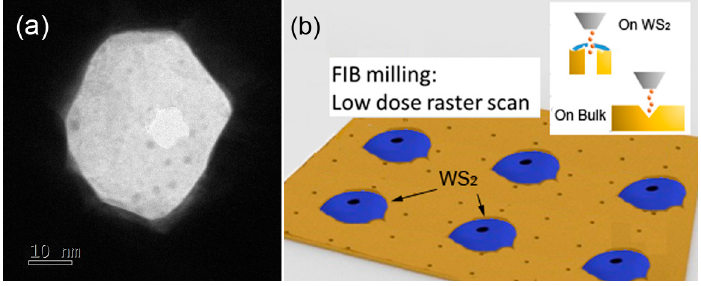
Figure 7. ( a ) TEM micrograph of the nanopore prepared into the 2D layer; ( b ) schematic illustration the FIB milling over the of the FIB milling over the array.